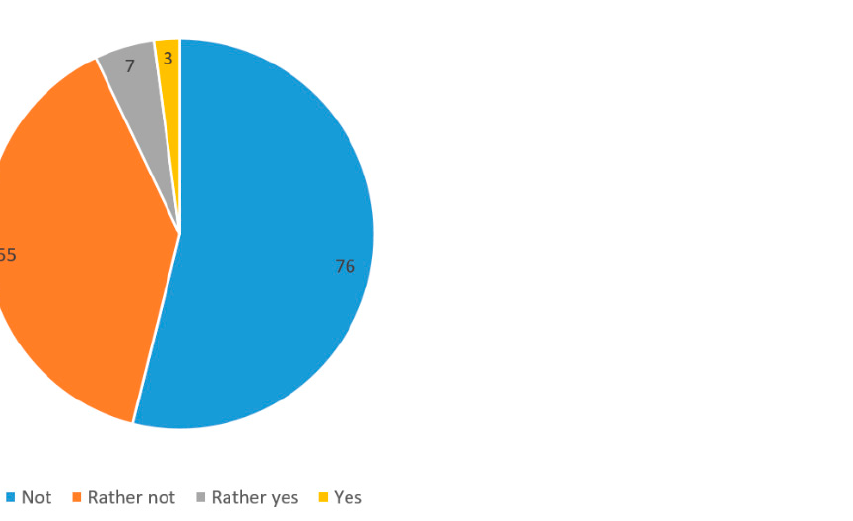
Figure 3. Expectations for extra-work compensation (absolute frequency, n = 141).